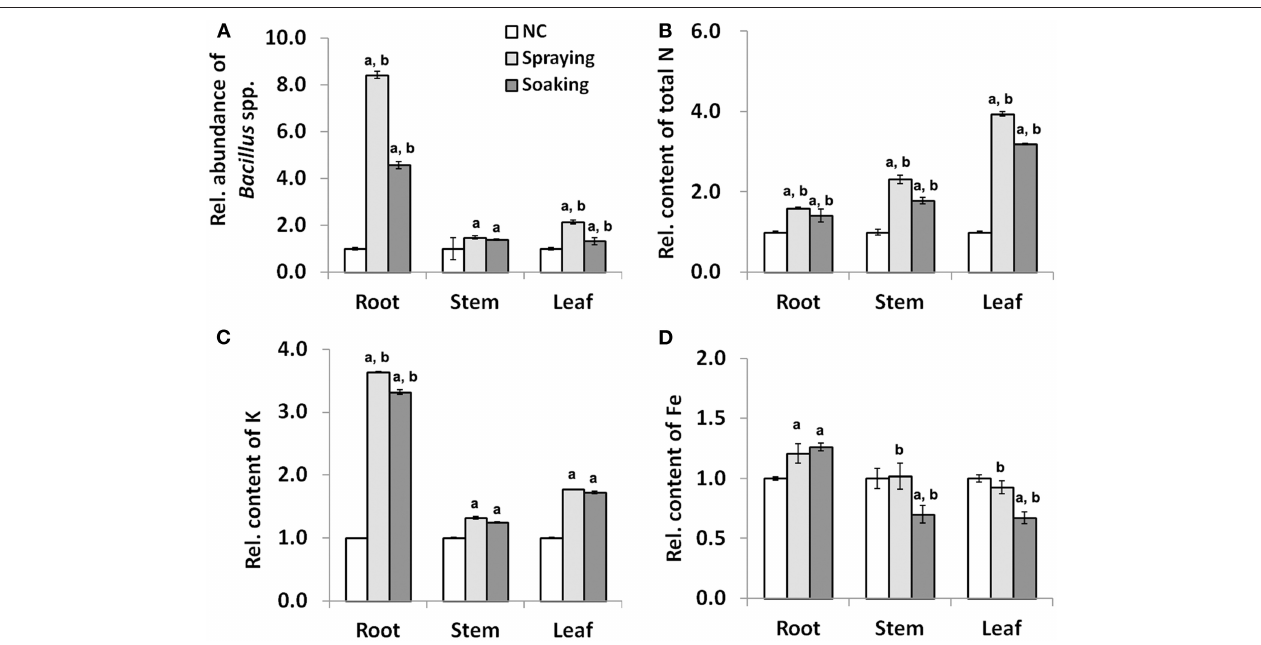
FIGURE 2 | Effect of WR10 inoculation on the abundance of endophytic Bacillus spp. and nutrient content in different wheat tissues at the grain filling stage. (A) The relative abundance of endophytic Bacillus spp. in different wheat tissues; (B) Relative content of N in different wheat tissues; (C) Relative content of K in different wheat tissues; (D) Relative content of Fe in different wheat tissues. Content of macronutrients was calculated as mg/g, and that of micronutrients was calculated as mg/kg dry weight. Original data were analyzed by pair-wise comparisons using LDS test, and p < 0.05 was considered significant. All data in the figure were normalized to their respective counterparts in the control group (NC) without inoculation of bacteria. In spraying, soils were sprayed with B. altitudinis WR10 before sowing of wheat; in soaking, wheat seeds were soaked in B. altitudinis WR10 suspension before sowing; a, statistically different from NC; b, significantly different between spraying and soaking groups.